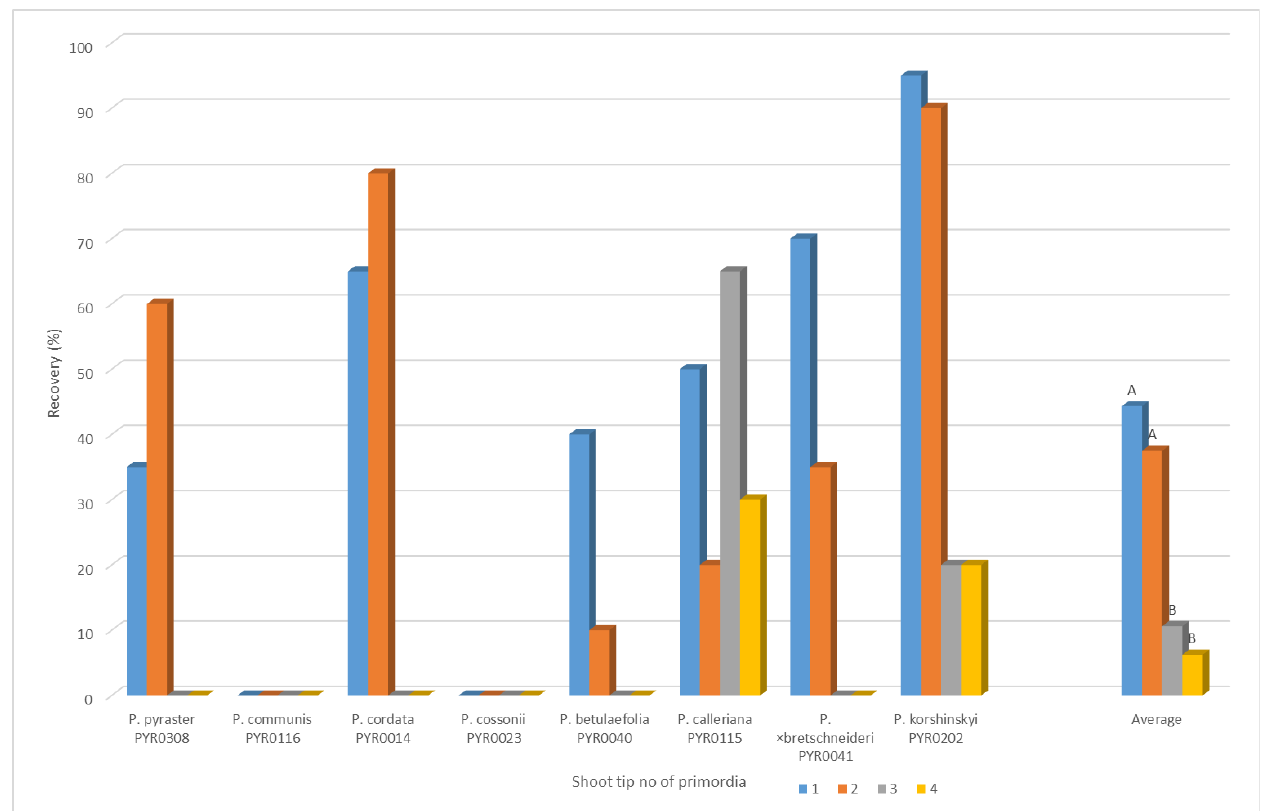
Figure 3. Cryopreservation of Pyrus by using PVS2 vitrification: Recovery rate (%) of Pyrus ssp . shoot tips after cryopreservation depending on the size of the explant. For each variant = 20 shoot tips. Means with the same letters are not significantly different ( p ≤ 0.05).